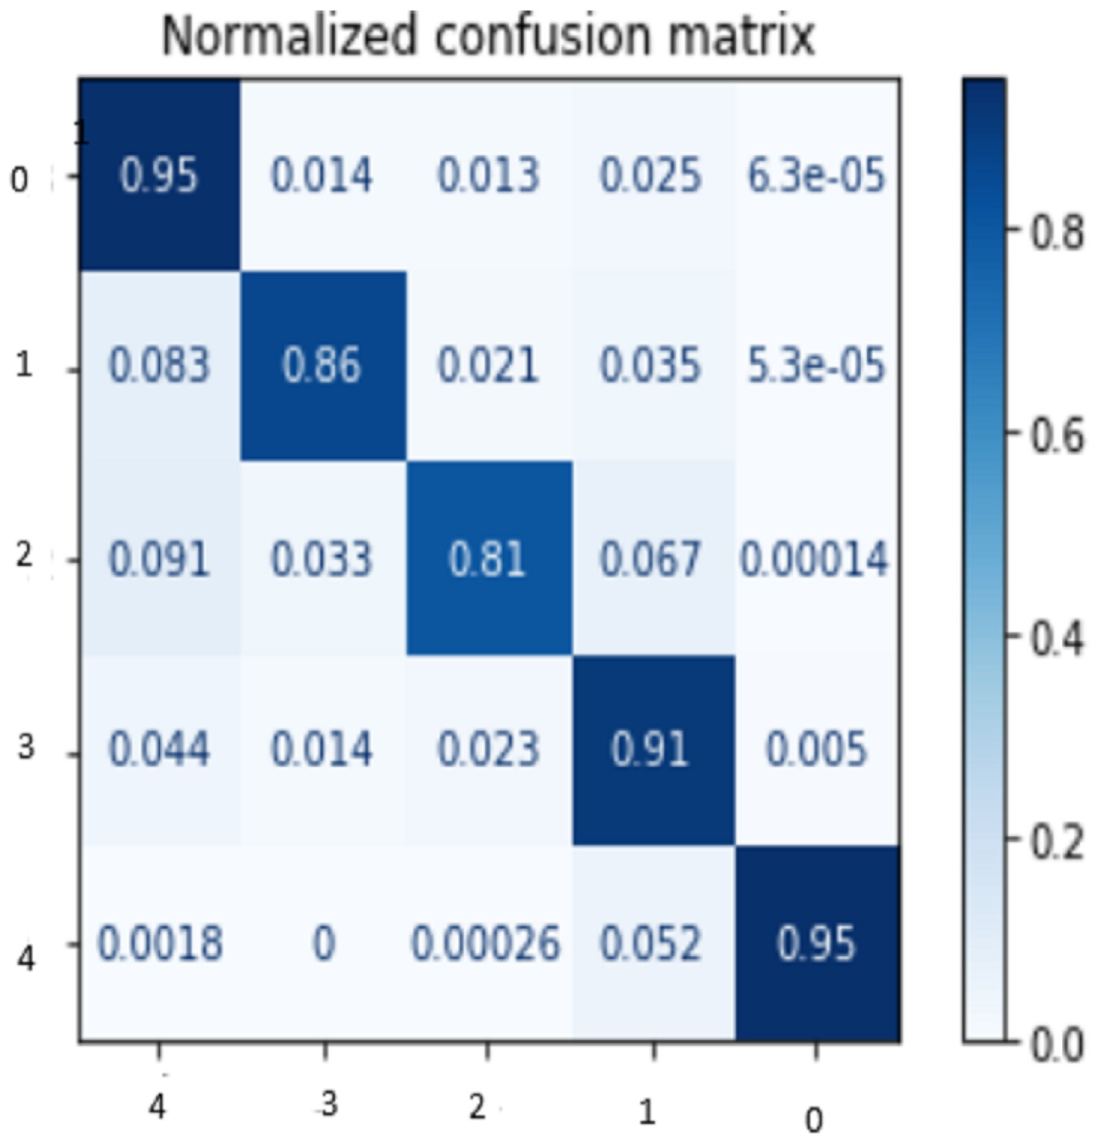
Fig 12. Confusion matrix for random